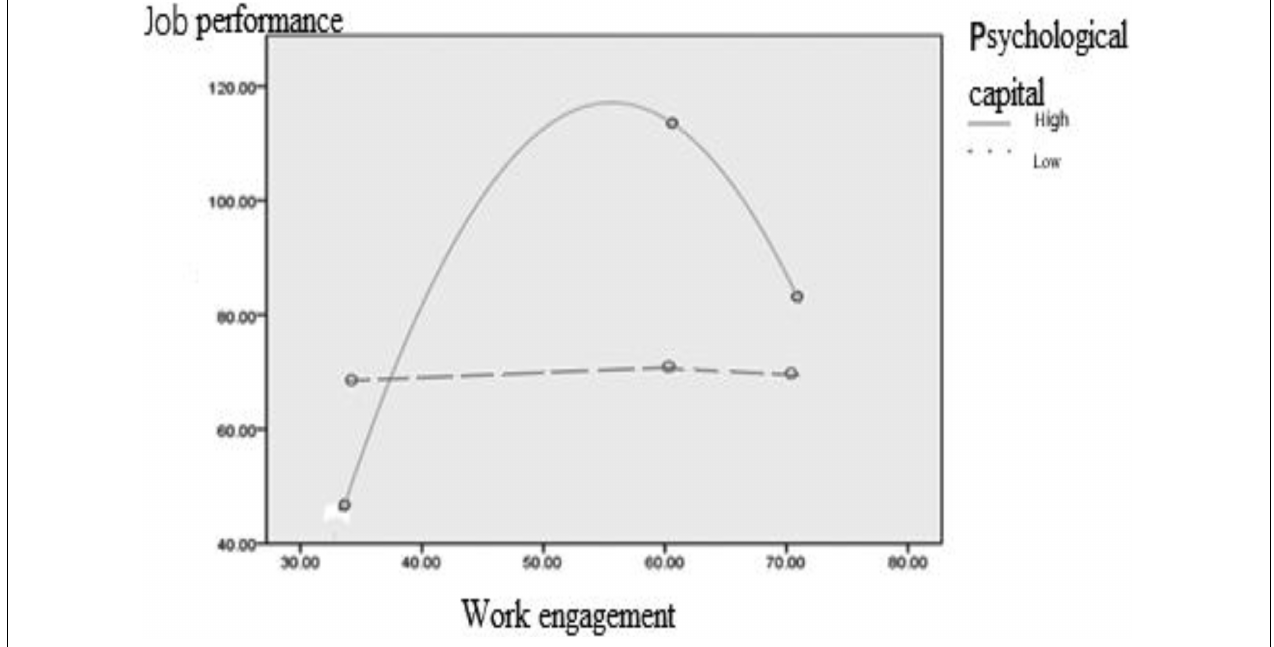
FIGURE 2 | The moderating effect of psychological